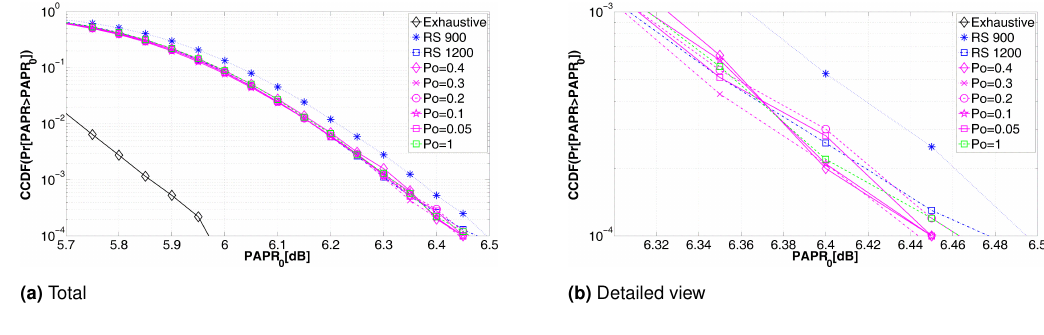
Fig. 3. PARP reduction performance comparison of GOBBO-PTS algorithm with different opposition probability values.